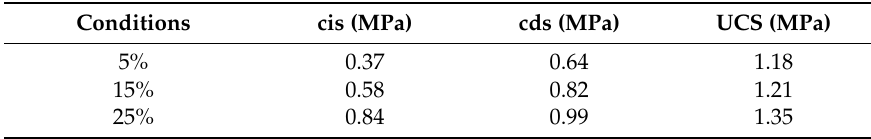
Table 8. Stress threshold values of brine-saturated